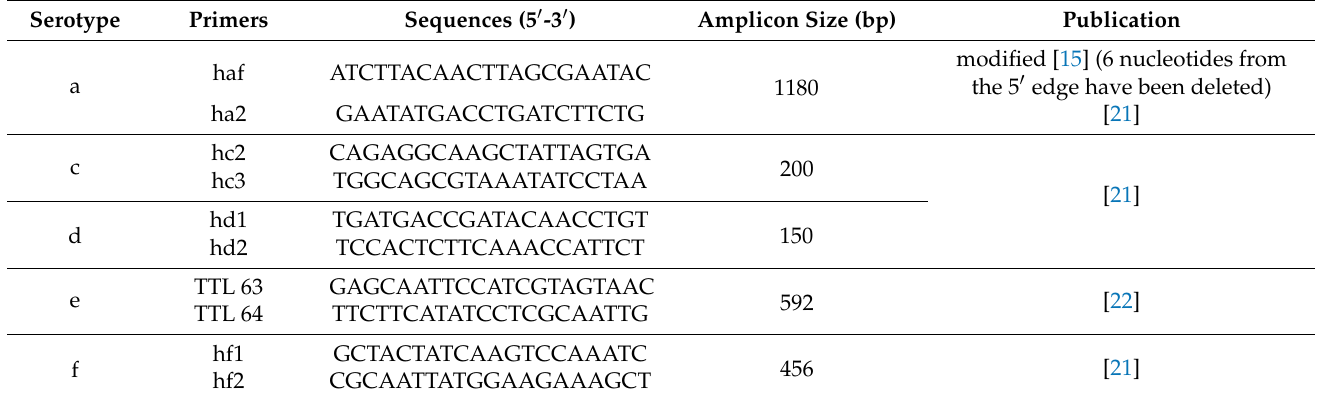
Table 1. Oligonucleotide primers used for the identification of H. influenzae serotypes.